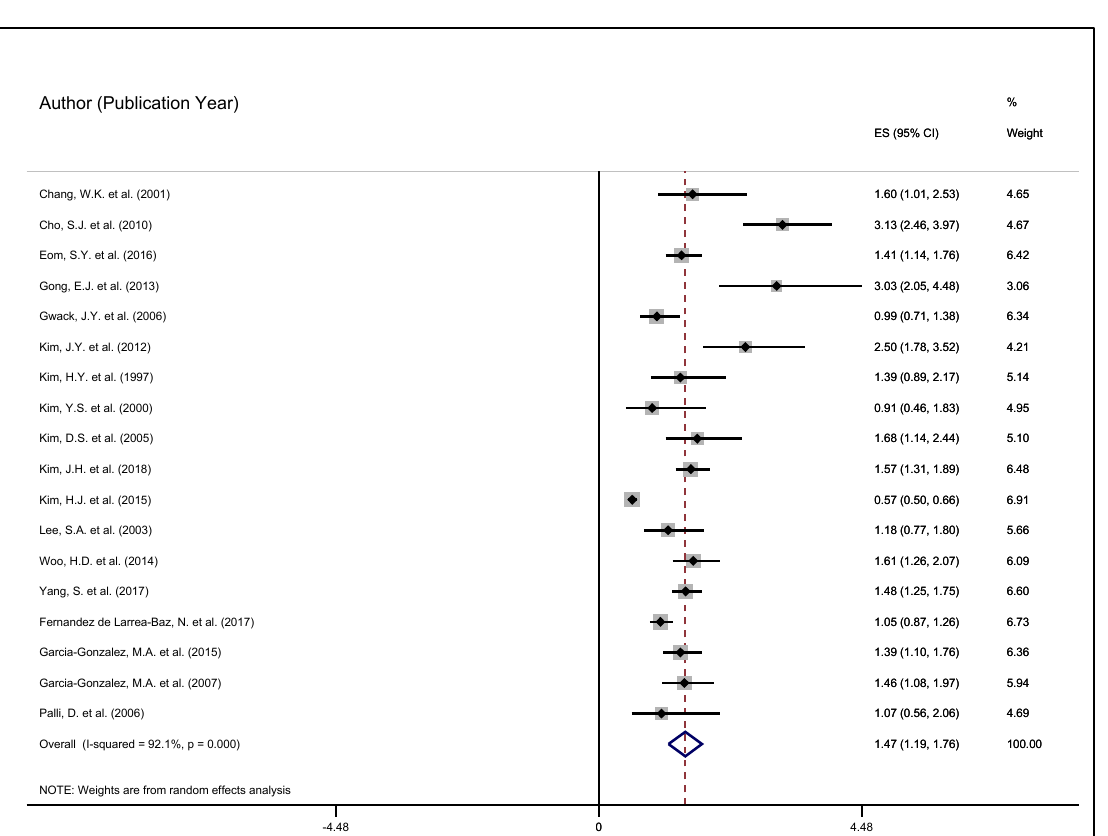
Abbreviations for Table 1 and 2: Gastric carcinoma (GC); gastric non-cardia carcinoma (GNCC); odds ratio (OR); body mass